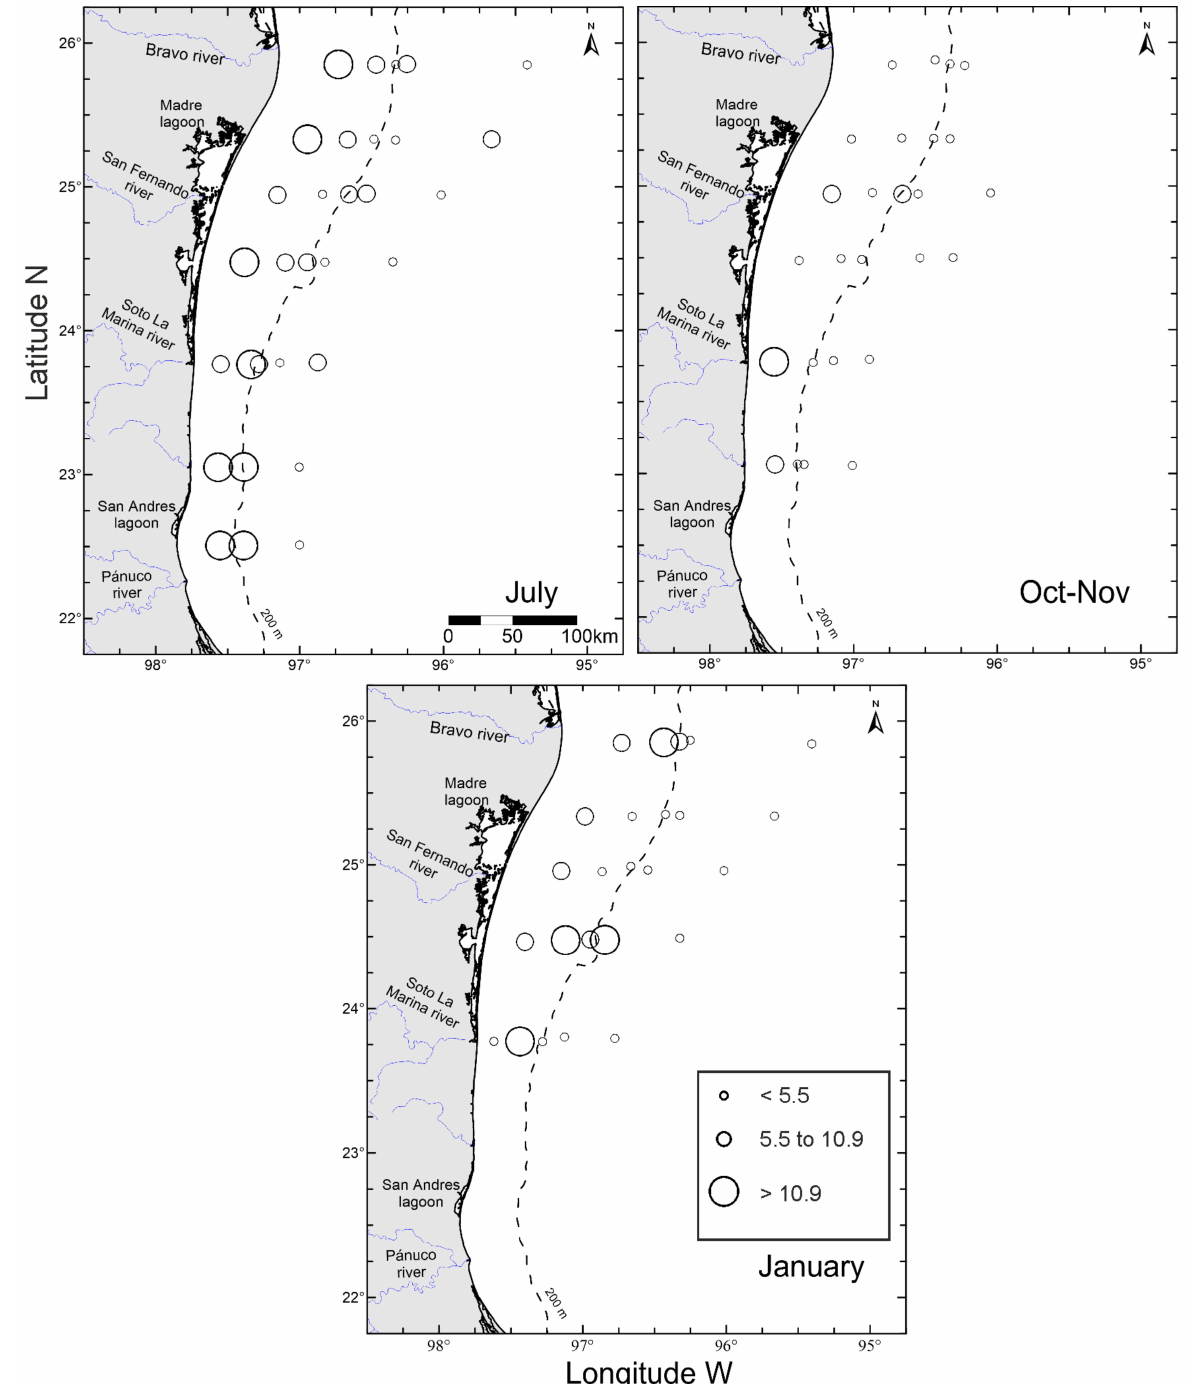
Figure 5. Distribution of zooplankton biomass (g 100 m − 3 ) values in the western Gulf of